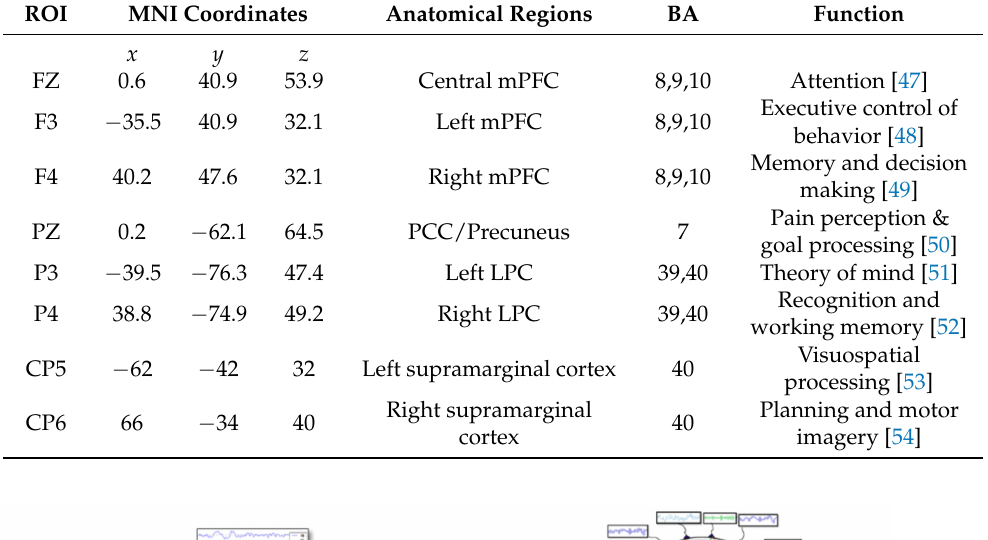
Table 2. EEG electrodes, ROIs, default mode network region underneath, and MNI coordinates with Brodmann areas (BA) and functions.